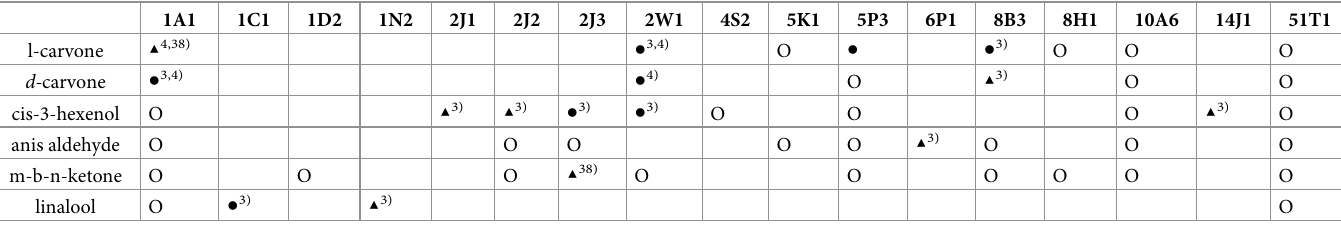
Table 1. ORs for each odorant a